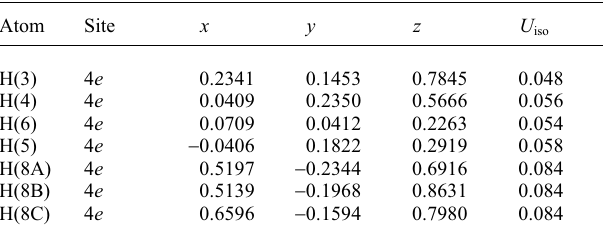
Table 2. Atomic coordinates and displacement parameters (in Å 2 )